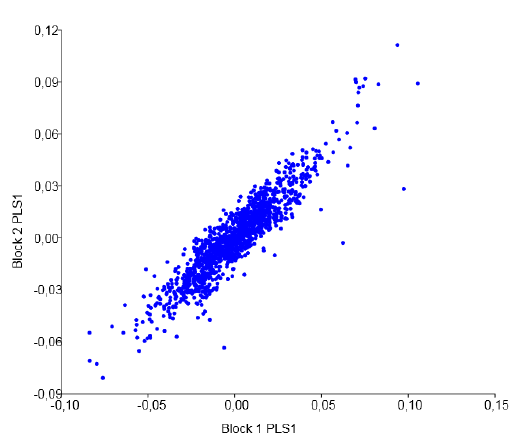
Figure 3. Regression between two blocks (block 1 is left and block 2 is right